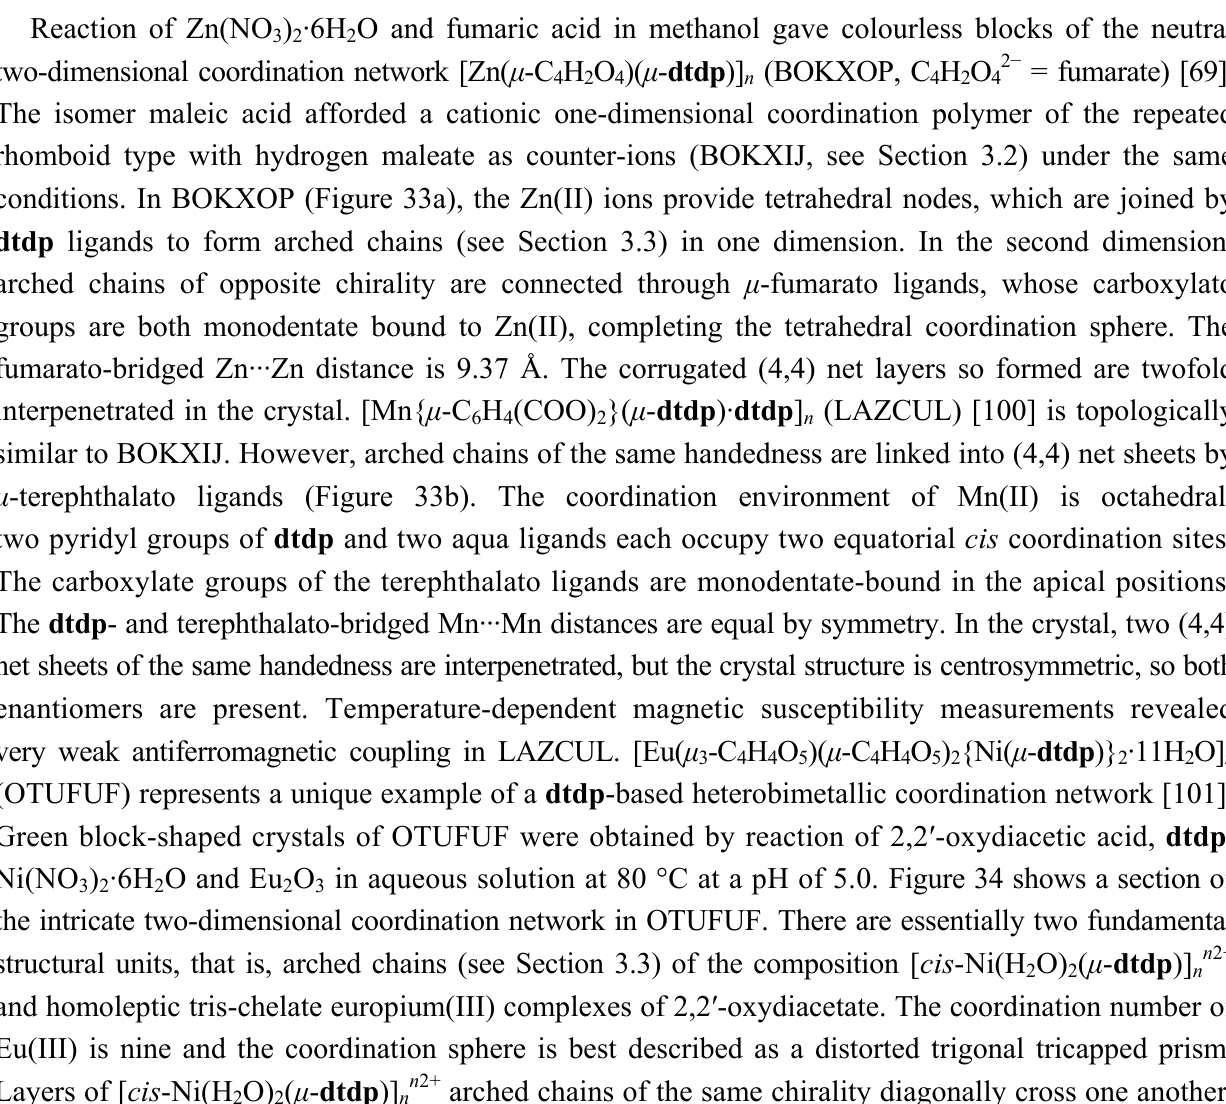
{ μ - C H (COO) } ( μ -dtdp ) 2 6 8 2 2